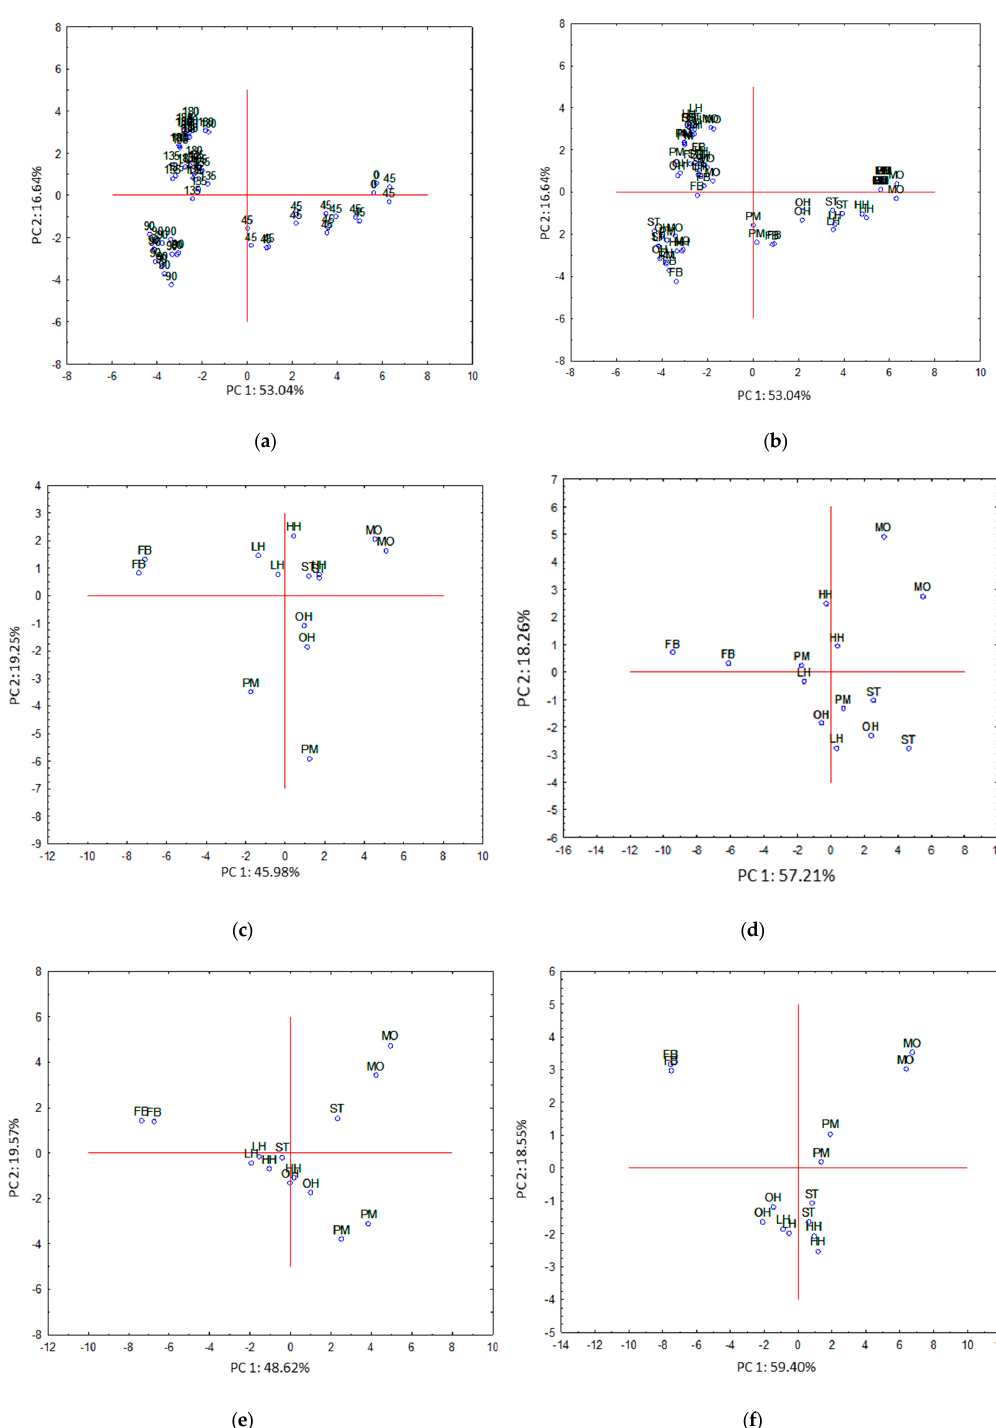
Figure 4. Principal Component Analysis (PCA) performed with copigmentation, color parameters and individual anthocyanins in wines from different aging systems. Evolution of wine during the time ( a ) and different systems ( b ); Differentiation of wines in the sampling performed: ( c ) 45 days; ( d ) 90 days; ( e ) 135 days; and ( f ) 180 days from the beginning of aging. Aging systems: PM (polydimethylsiloxane tube); HH, LH and ÖH (high-density polyethylene); ST (stoneware); MOX (stainless steel with micro-oxygenation); and FB (French oak barrel). Table 4. Principal component analysis (PCA) results carried out with copigmentation, color parameters and individual anthocyanins in wines aged with different aging systems after different aging times (45, 90, 135 and 180 days).